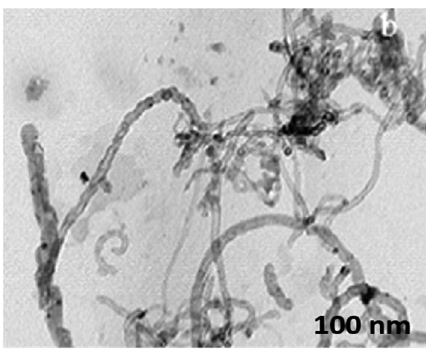
Figure 16: TEM image of Al – Cu – Mg – T351 + 0.5% MWCNT